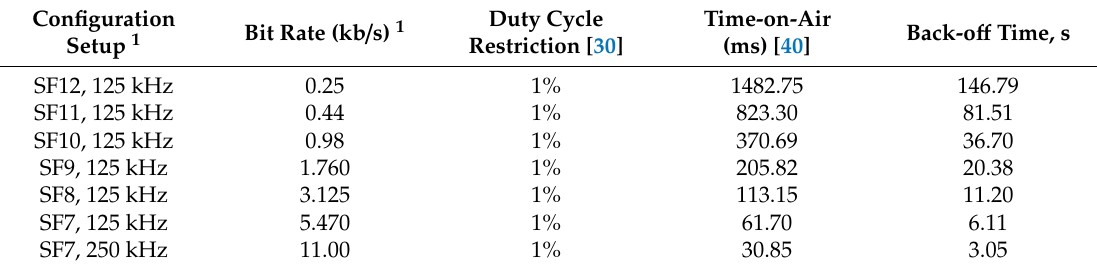
Table 2. Time-on-air for LoRaWAN packets with di ff erent spreading factors (SFs) and the